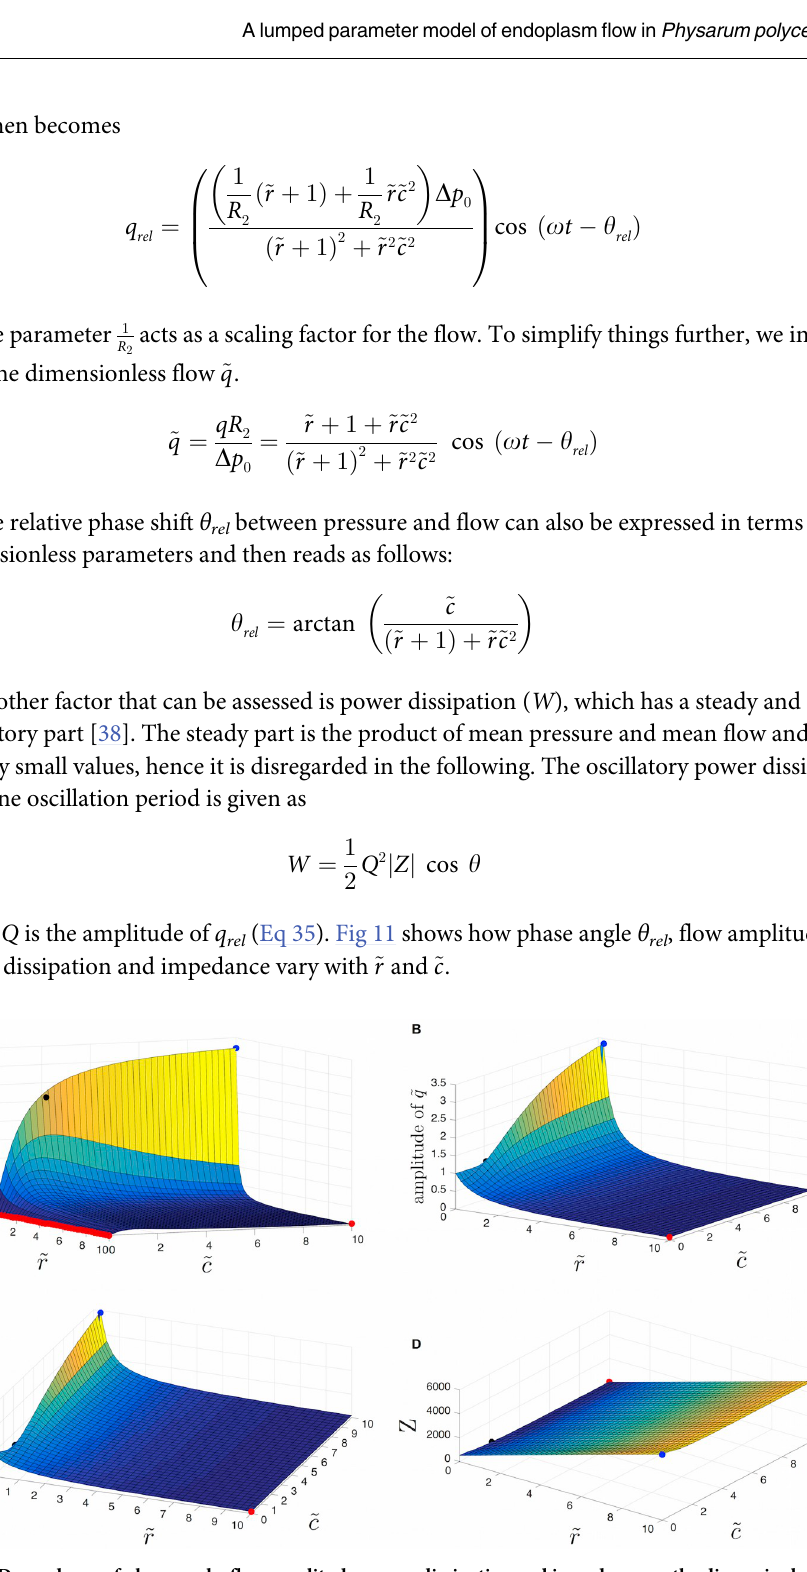
Fig 11. Dependence of phase angle, flow amplitude, power dissipation and impedance on the dimensionless parameters ~ r and ~ c . Illustration of how θ (A), amplitude of the flow ~ q (B), power dissipation W (C), and impedance rel Z (D) vary with the dimensionless parameters ~ r and ~ c . Red dots = local minima, blue dots = local maxima, black dots = corresponding values for calculated ~ r and ~ c .